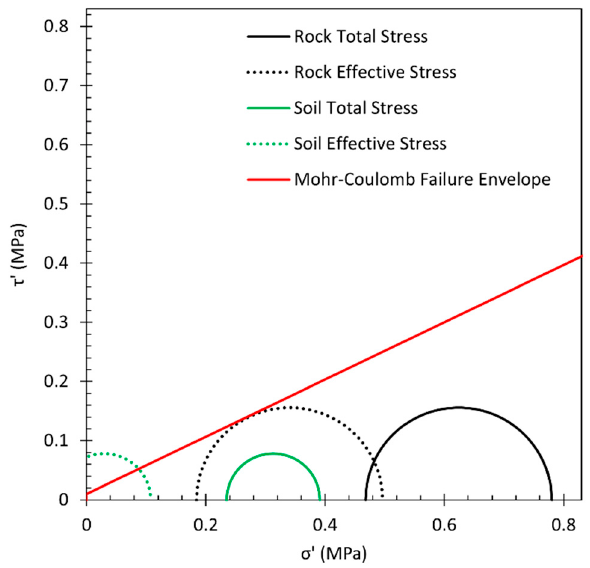
Figure 3. Mohr–Coulomb failure criteria for dry soil and rock (green and black, respectively) and a “seepage” soil/rock assuming complete seepage of the hydrostatic head of water.